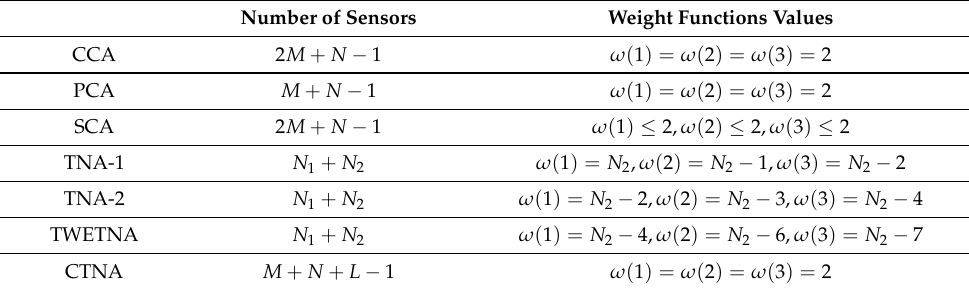
Table 3. Weight function comparison of different sparse